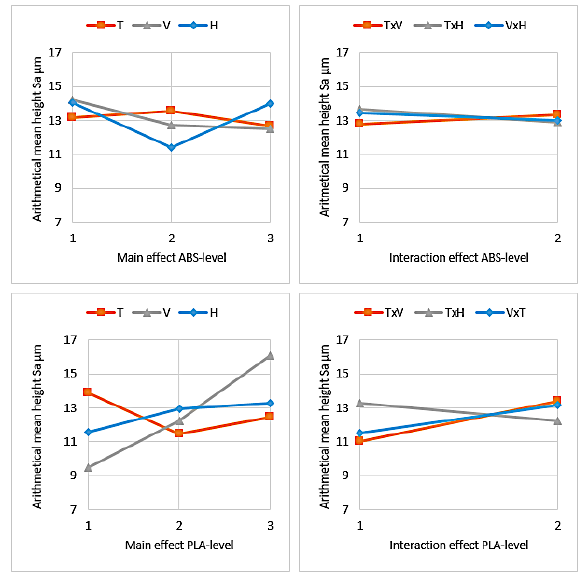
Figure 8. Main and interaction effect on wettability main effect analysis.